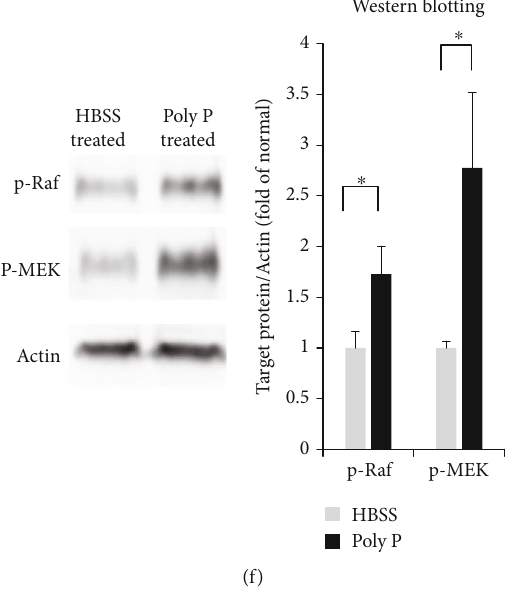
Figure 5: The supernatant of poly P-treated PRP activated the ERK signaling pathway and increased the wound healing e ff ect in epithelial cells. Western blotting showed that the activation of ERK, p38, Akt, and JNK was induced by treatment with the supernatant of poly P- treated PRP (a). The activation of ERK, p38, Akt, and JNK was inhibited by FR180204, SB203580, LY294002, and SP600125, respectively. The wound healing e ff ects by the supernatant of poly P-treated PRP were signi fi cantly decreased by the inhibition of ERK, but not p38, Akt, or JNK signaling (b – e) according to a two-factor ANOVA. Western blotting showed that upstream Raf-MEK-ERK signaling was activated (f). The error bars and numbers show the standard deviation. ∗ P < 0 : 05 by Student ’ s t -test (a,